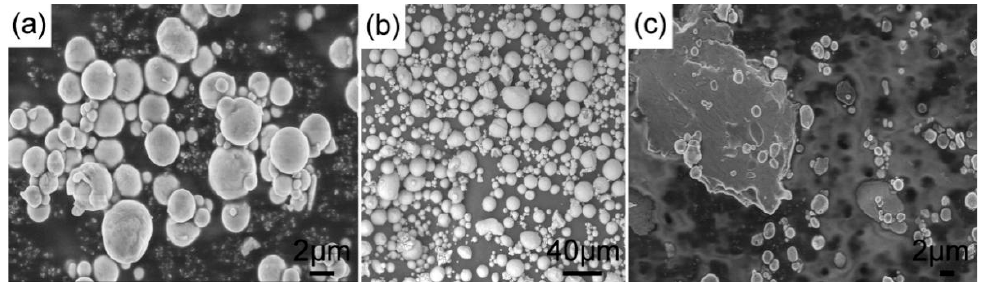
Figure 2. SEM images that reveal the powder morphologies and sizes. ( a ) the raw Al powder; ( b ) the raw CrCoNi powder; ( c ) the mixed Al and CrCoNi